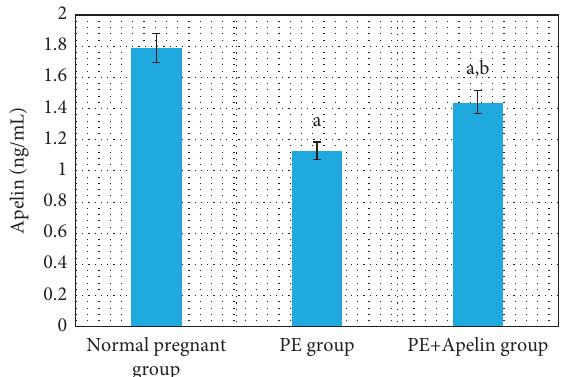
Figure 1: Serum apelin concentration in the studied groups.